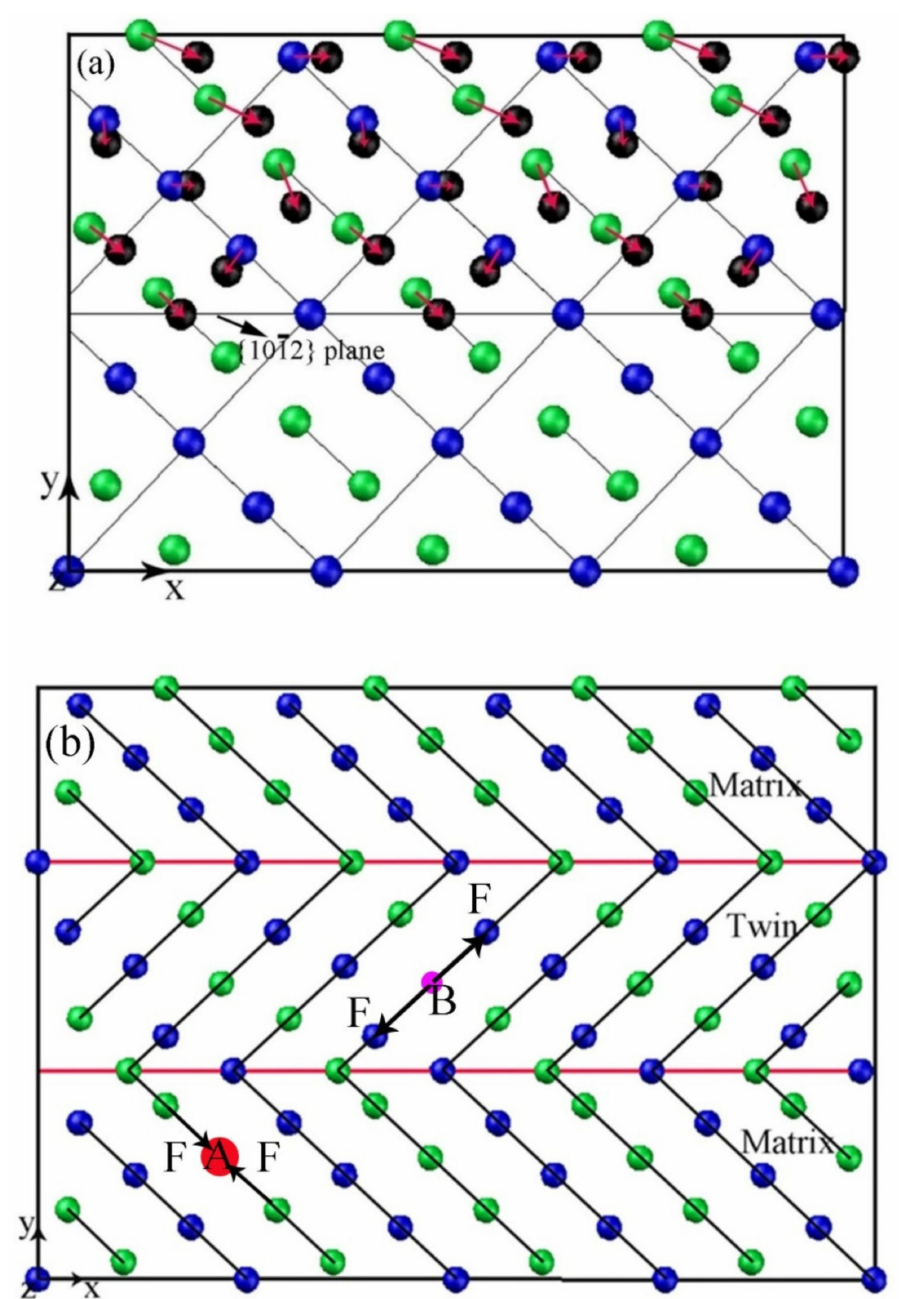
Figure 8. ( a ) Schematic drawing showing atomic motion in the twinning area, ( b ) Schematic drawing illustrating the relation between Mg and solute